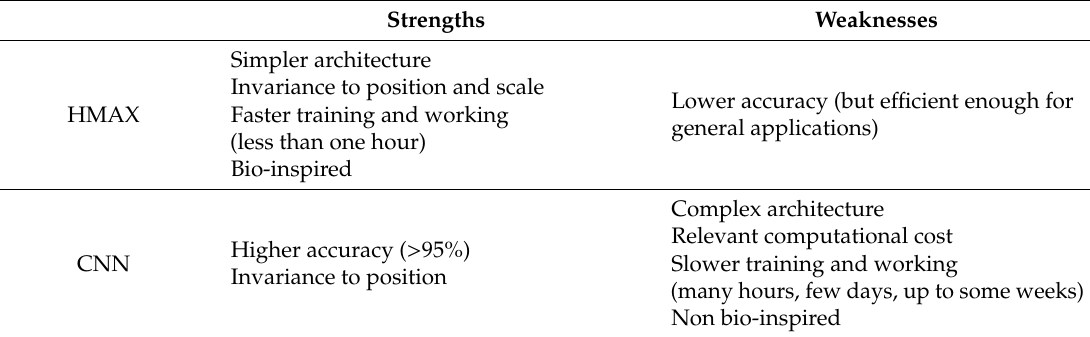
Table 1. Comparative between Hierarchical Max-pooling (HMAX) and Convolutional Neural Network (CNN) computational